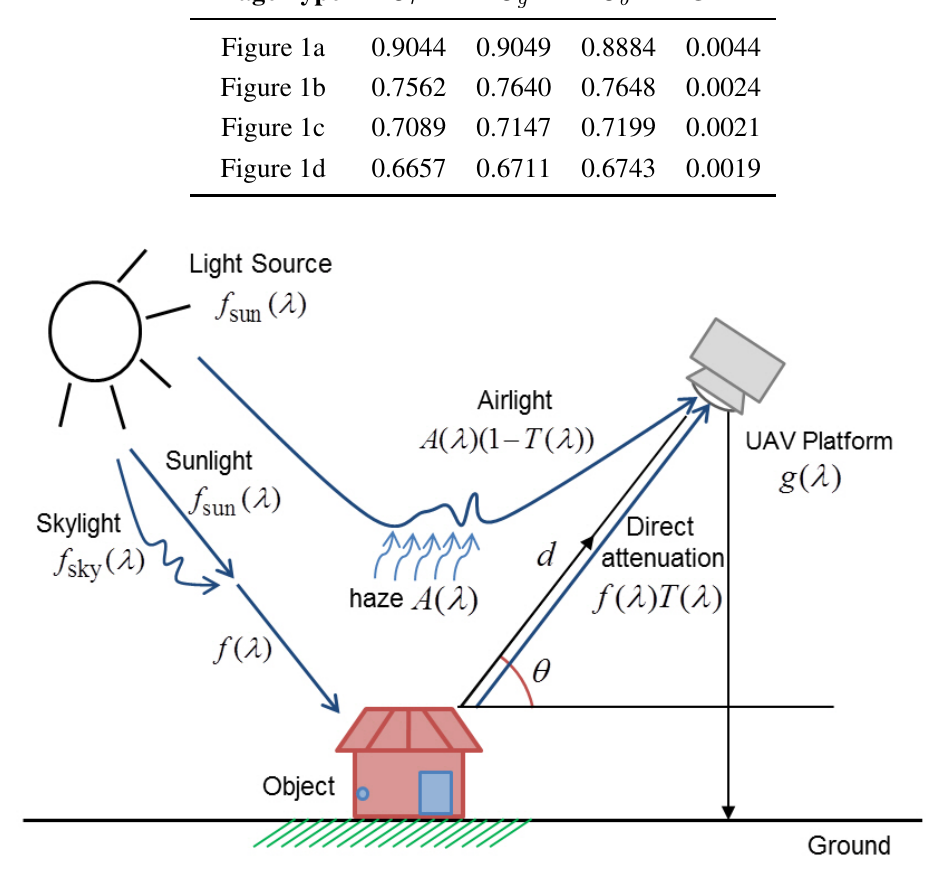
Figure 4. The proposed wavelength-adaptive UAV image formation model in a hazy atmosphere acquired by a UAV platform. f sun and sky light. The sky light f in the